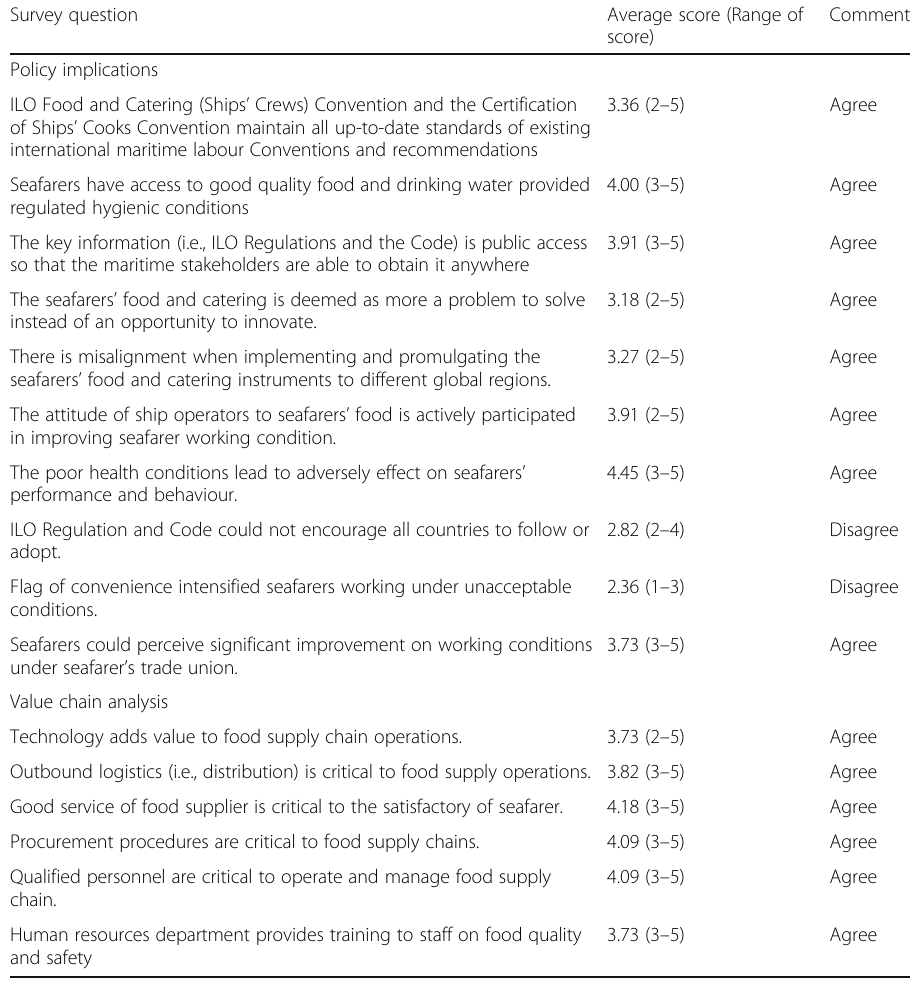
Table 2 Questionnaire survey - summary of survey